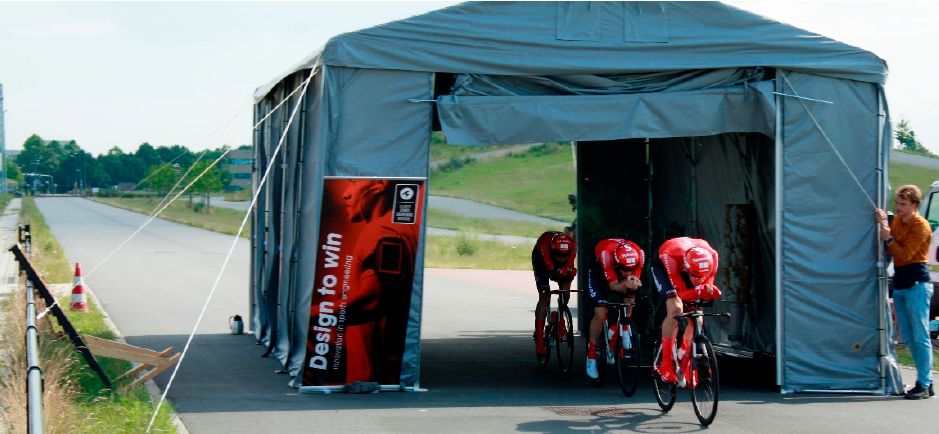
Figure 1. Picture of a drafting configuration passing through the Ring of